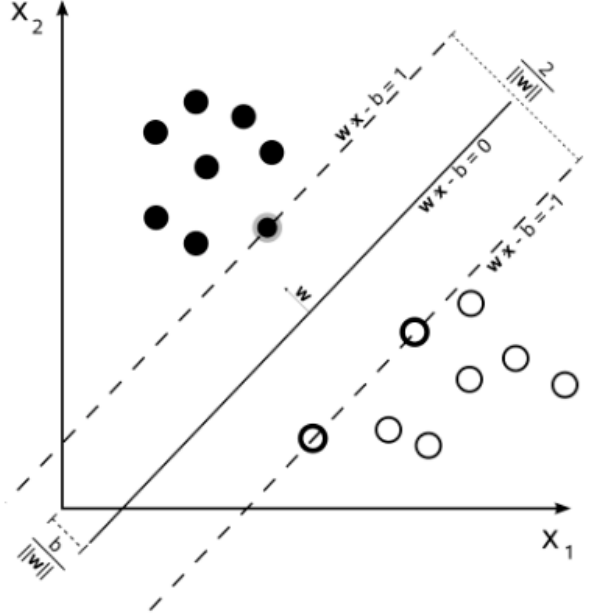
Figure 9. Optimal classification surface in two-dimensional.